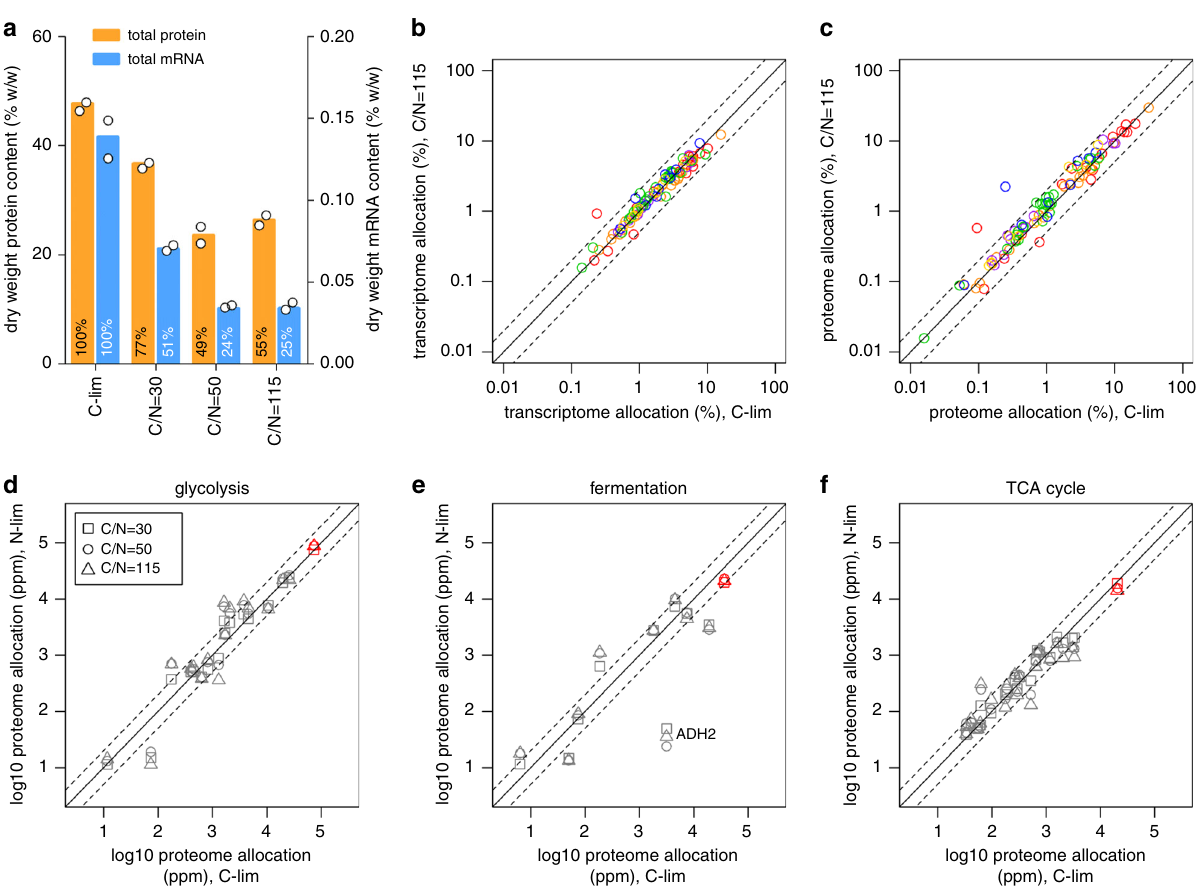
Fig. 2 Transcriptome and proteome reserves for different cellular processes. a Total protein and mRNA content of the biomass under each culture condition. Colored bars are mean of biological duplicates. b Transcriptome allocation (% mol mol − 1 ) to 99 GO-slim terms were compared between N-limited and C-limited cultures. GO-slim terms are color-coded by functional category as in Fig. 1b. Dashed lines are twofold increase and decrease from y = x , solid line. Mean values for carbon-limited and C/N = 115 conditions are shown. The red outlier represents the “ amino acid transport ” GO-slim term. c As in b for proteome allocation. The red and blue outliers represent “ amino acid transport ” and “ response to starvation ” GO-slim terms, respectively. d Proteome allocation to each enzyme in glycolysis was compared between N-limited (C/N = 30, 50, and 115) and C-limited cultures. Total proteome allocation to all enzymes in glycolysis is shown in red. Dashed lines are twofold increase/decrease from y = x , solid line. ppm, parts per million (mol mol − 1 ). e As in d for proteome allocation to enzymes in fermentation. Total proteome allocation to all enzymes in fermentation is shown in red. Dashed lines are twofold increase/decrease from y = x , solid line. f As in d for proteome allocation to enzymes in the TCA cycle. Total proteome allocation to all enzymes in the TCA cycle is shown in red. Dashed lines are twofold increase/decrease from y = x , solid